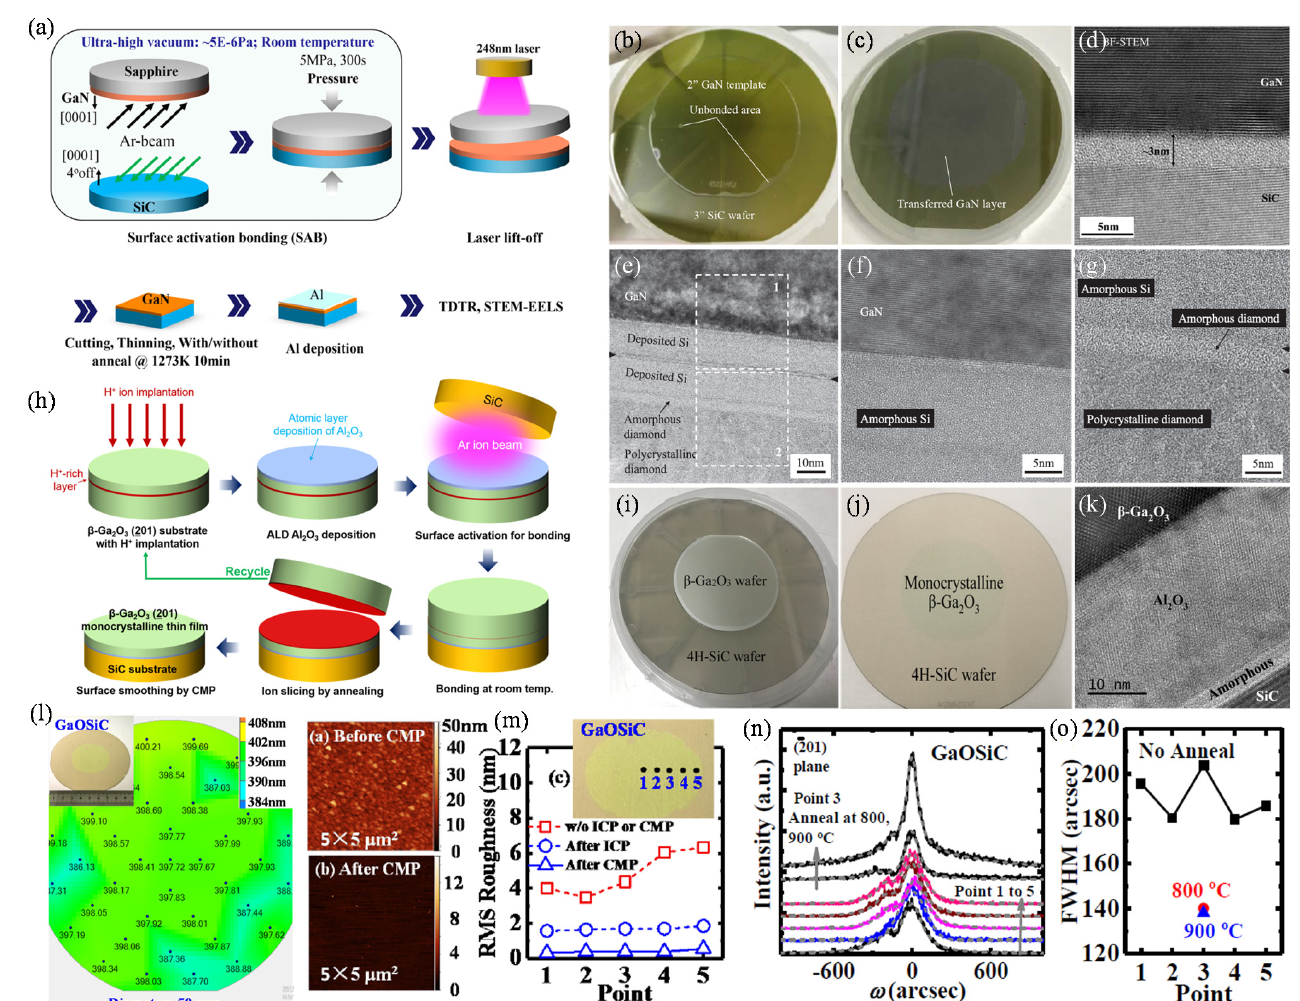
Figure 4. Heterogeneous bonding for wide-bandgap semiconductors thin-film transfer onto SiC or diamond substrates for high heat dissipation. ( a ) The schematic diagram for GaN thin-film transfer onto the SiC substrate via Si-modified SAB method [12]. ( b ) Optical image of the bonded GaN and SiC wafers via Si-modified SAB method [12]. ( c ) Optical image of the transferred GaN thin film onto SiC substrate [12]. ( d – g ) TEM images of the GaN/SiC bonding interface [12]. ( h ) The schematic diagram for Ga 2 O 3 thin-film transfer onto the SiC substrate via Al 2 O 3 -modified SAB method [121]. ( i ) Optical image of the bonded Ga 2 O 3 and SiC wafers via Al 2 O 3 -modified SAB method [121]. ( j ) Optical image of the transferred Ga 2 O 3 thin film onto SiC substrate [121]. ( k ) TEM images of the Ga 2 O 3 /SiC bonding interface [121]. ( l ) Thickness and AFM measurements for the transferred Ga 2 O 3 thin film onto SiC substrate [90]. ( m – o ) Material characterizations of the transferred Ga 2 O 3 thin film [90]. Reprinted with permission from ref. [12]. Copyright 2019 American Chemical Society. Reprinted with permission from ref. [121]. Copyright 2020 American Chemical Society. Reprinted with permission from ref.